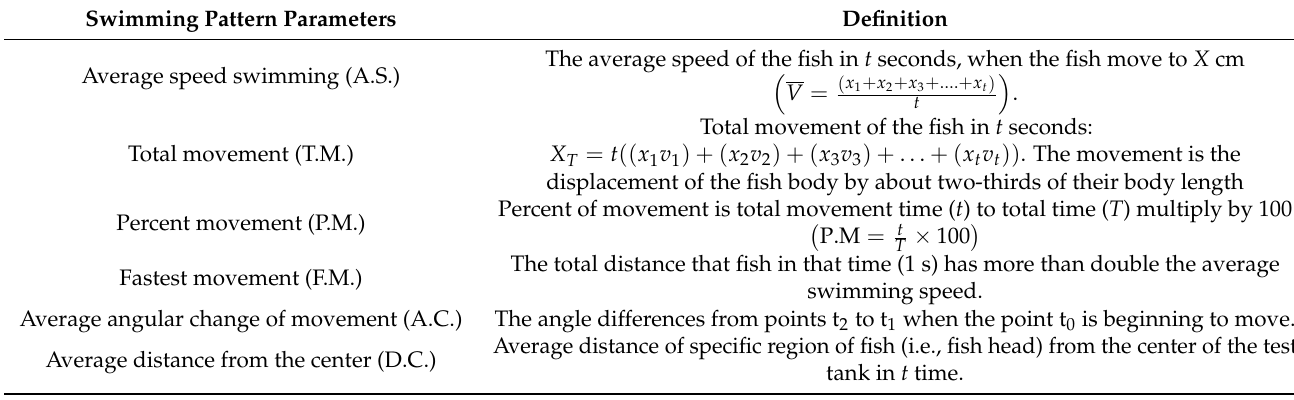
Table 1. Parameters of swimming patterns of fish, that are used in the present study as characteristics of behavioral responses of common carp ( Cyprinus carpio ) exposed to acute changes of environmental parameters (ammonia and temperature). Swimming Pattern Parameters Definition Average speed swimming